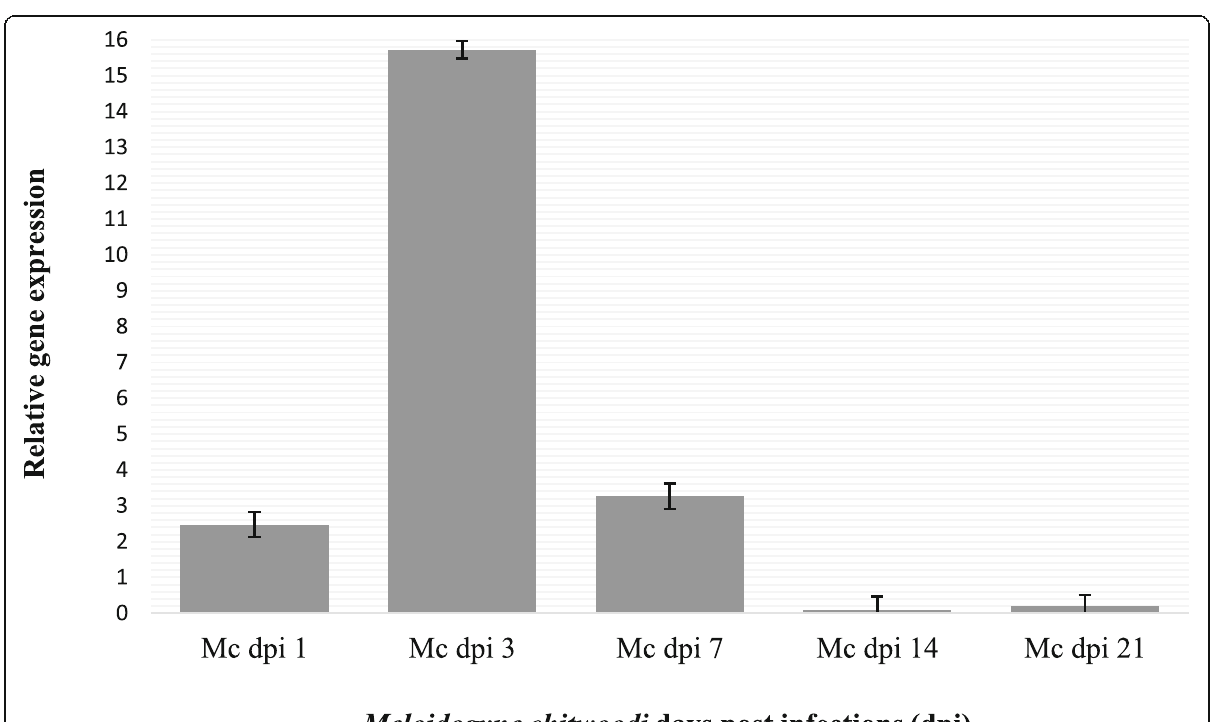
Fig. 4 Meloidogyne chitwoodi induced proteinase inhibitor I gene expression in host tissues at different days post-infections. Housekeeping gene Actin gene was used to normalize expression of genes of interest. Relative gene expression was calculated biological replicates using the 2 △△ Ct method and uninfected (control) values were subtracted from infected values. Y axis represents relative gene expressions, X axis indicates 1 dpi, 3 dpi, 7 dpi, 14 dpi, and 21 dpi following Meloidogyne chitwoodi infection. Error bars represents the standard error of the means of three replicates. Mc, Meloidogyne chitwoodi ; dpi, days post